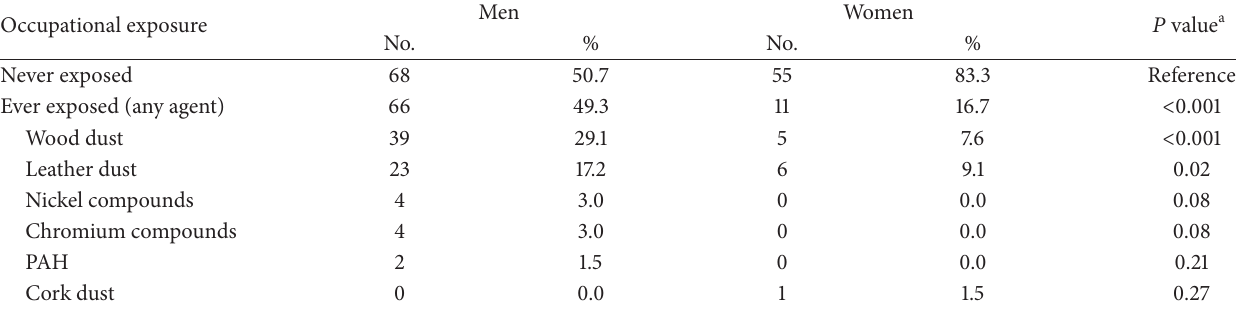
Table 2: Occupational exposure to carcinogenic agents among subjects with sinonasal cancer, by gender; Lombardy region sinonasal cancer registry, 2008–2011 ( 𝑁 = 200 with interview).